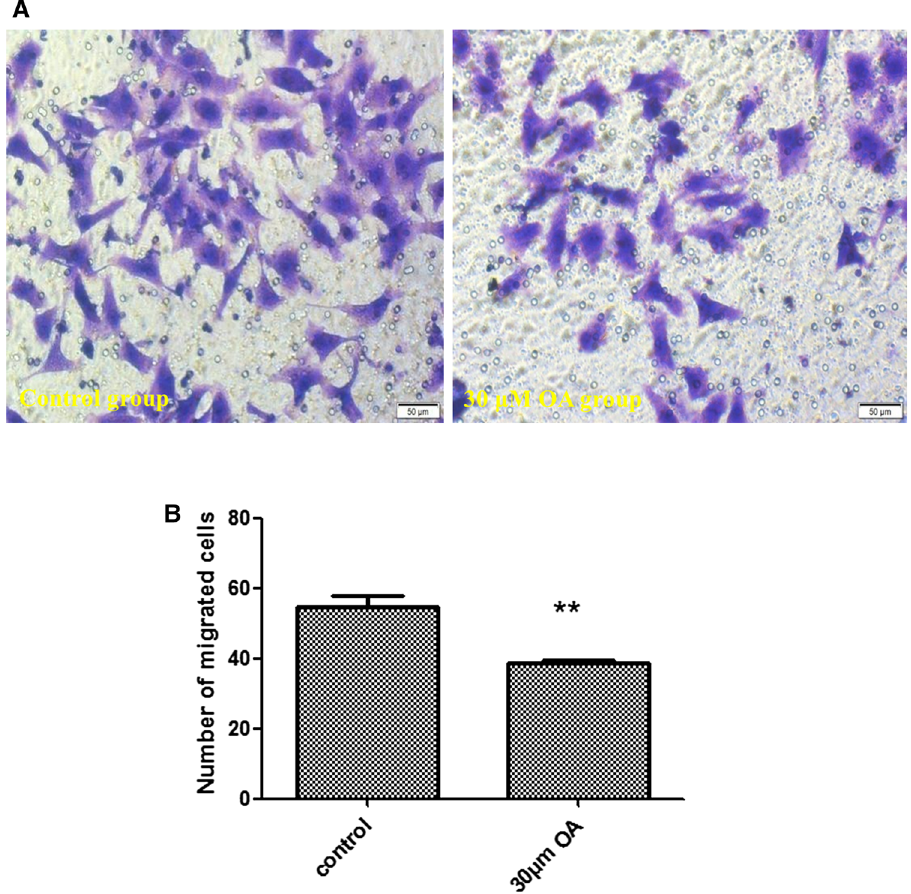
Figure 6. ( A ) Invasiveness of Hep-2 cells after 48 h of oleanolic acid (OA) exposure (200×). Left panel, Control group; right panel, 30 μM OA group). ( B ) Quantification of the invasiveness of Hep-2 cells following treatment with OA. ** P < 0.01, compared with the control